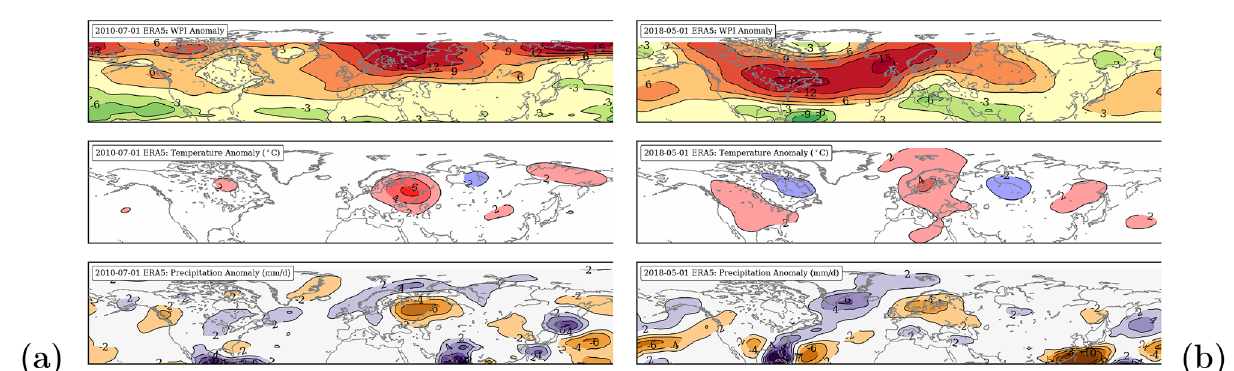
Figure 6. Observed patterns of WPI (top), temperature (center) and precipitation (bottom) anomalies averaged for July 2010 ( a ) and May 2018 ( b ) related to 1981–2010. The maps were created by using python3-mpltoolkits. basemap (version 1.2.1, https:// matpl otlib. org/ basem